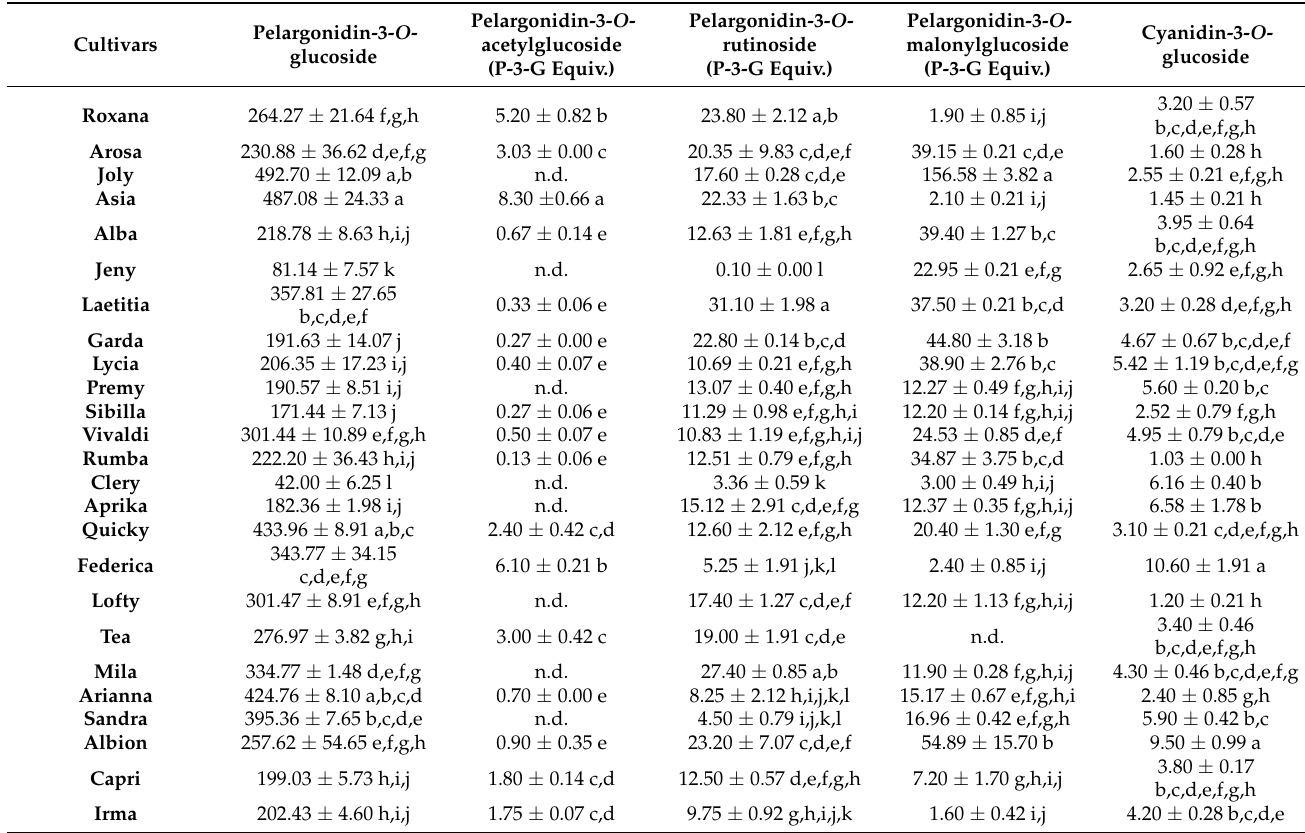
Table 3. Content ( µ g g − 1 of FW) of anthocyanins in strawberry fruit extracts.